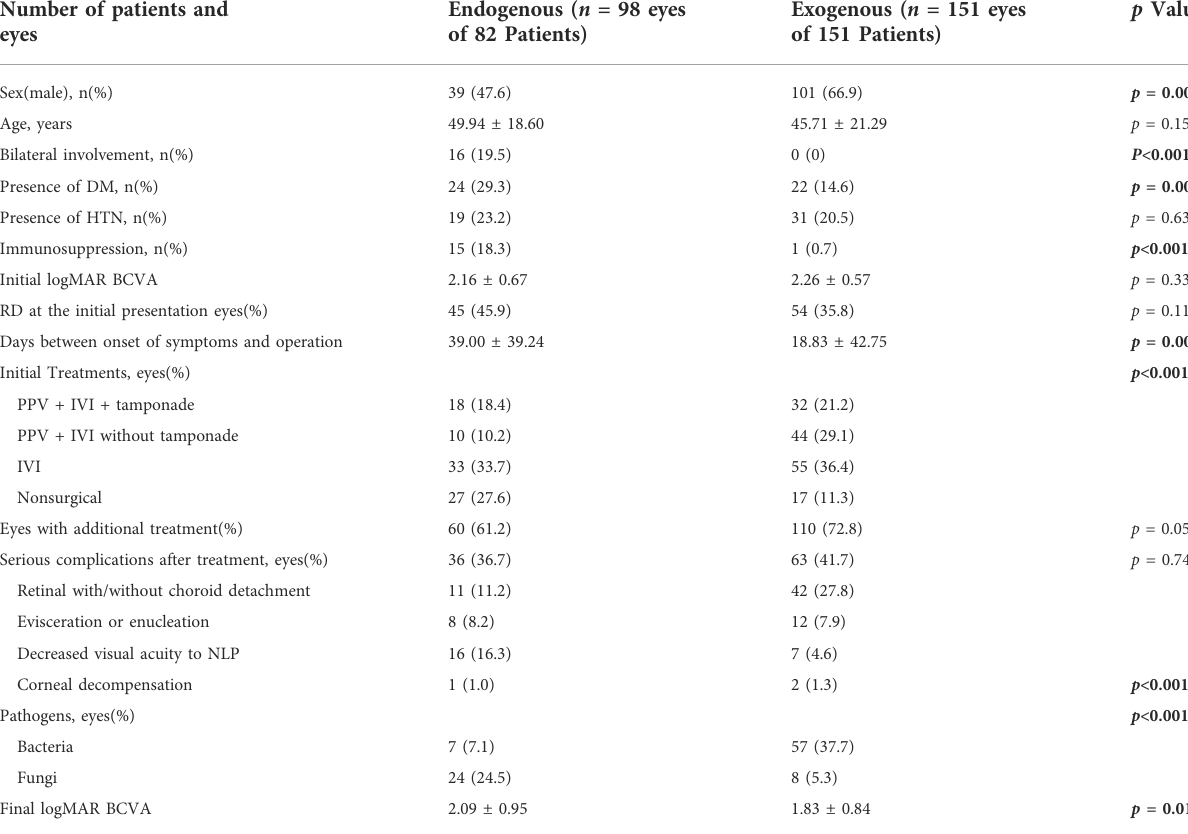
TABLE 2 Clinical characteristics and treatment outcomes of endogenous and exogenous